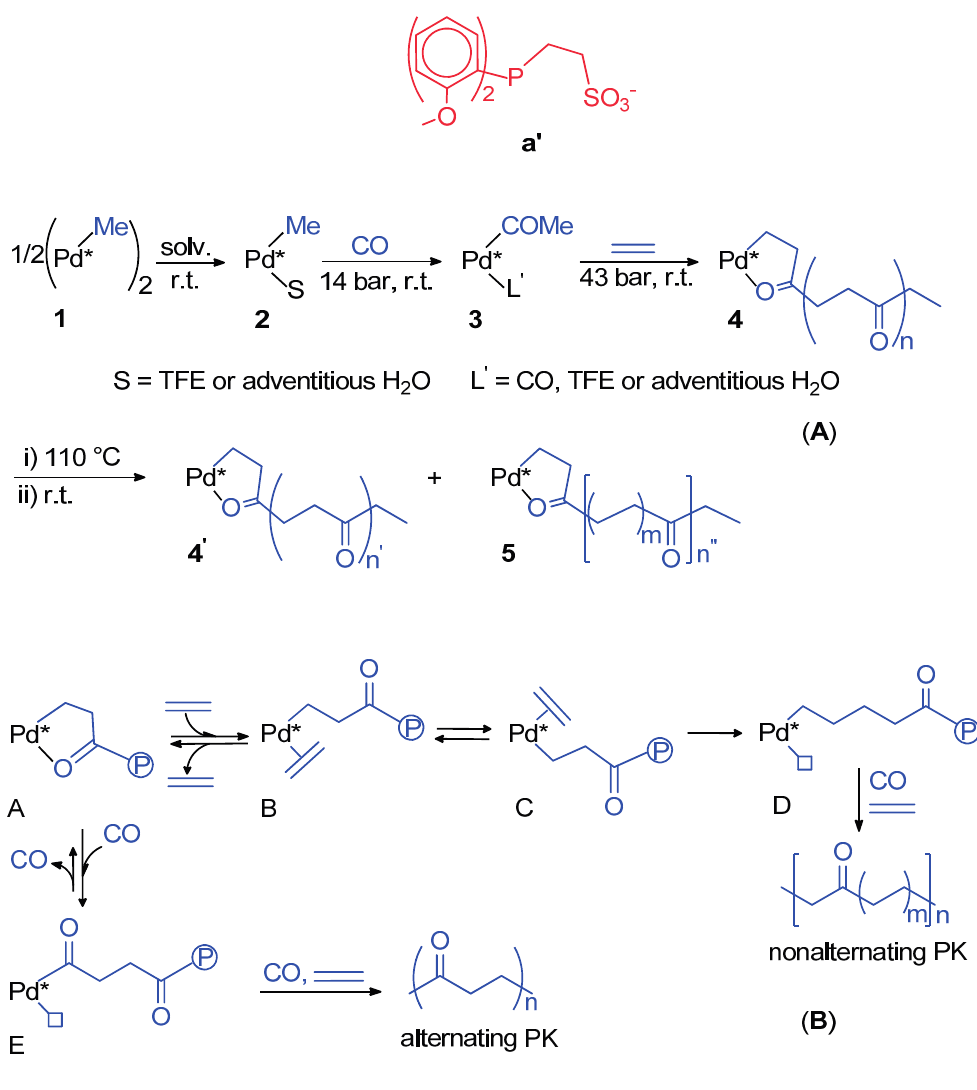
Figure 12. Reactivity of precursor 1 ( A ) and β -chelate opening by ethene and CO with formation of nonalternating and alternating chains, respectively ( B